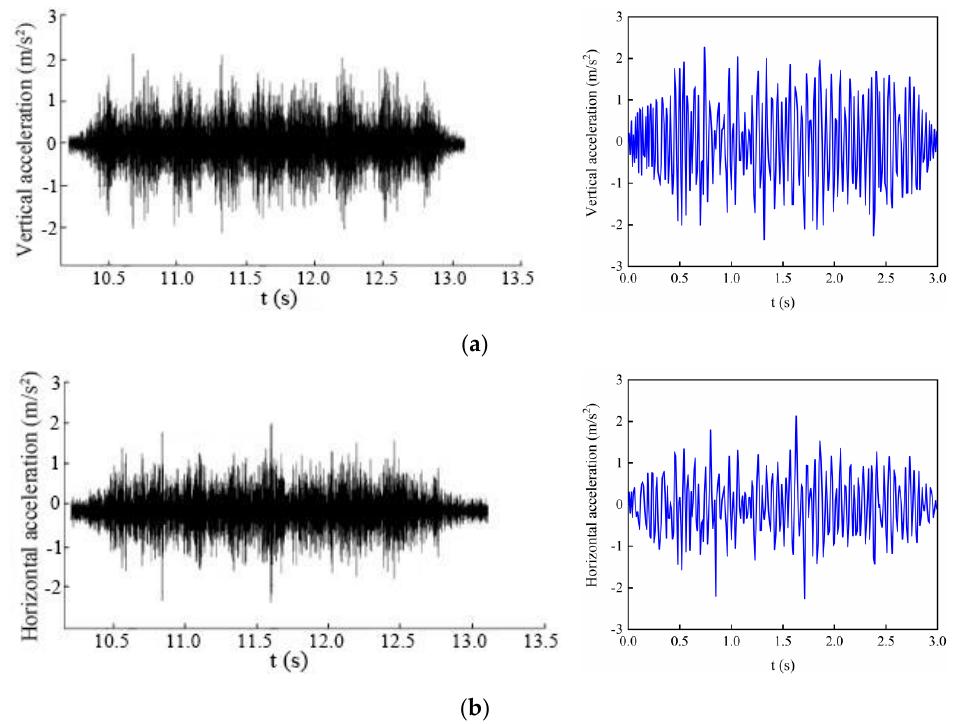
Figure 8. Measuring point acceleration time course curve: ( a ) vertical acceleration time – history curves of references and this paper; ( b ) the time – history curve of horizontal acceleration in the reference literature and this paper.